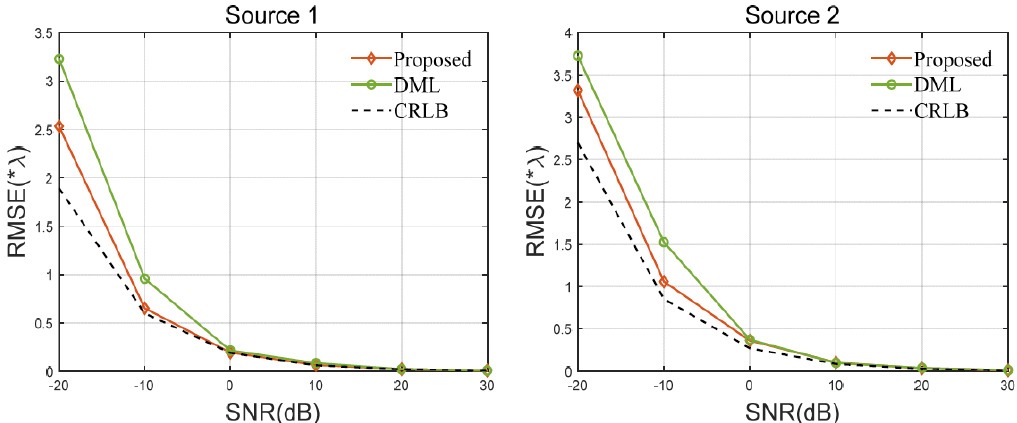
Figure 4. RMSE and CRLB versus SNR of the estimated parameter 𝑟.